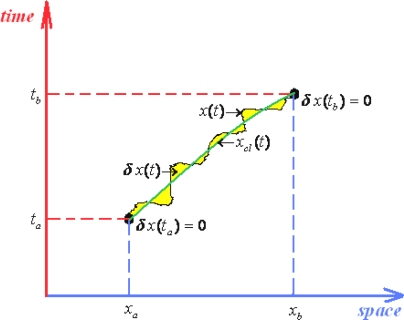
Illustration of the quantum fluctuations δx(t) around the classical path xcl (t) producing the space-time evolution of Figure 1.